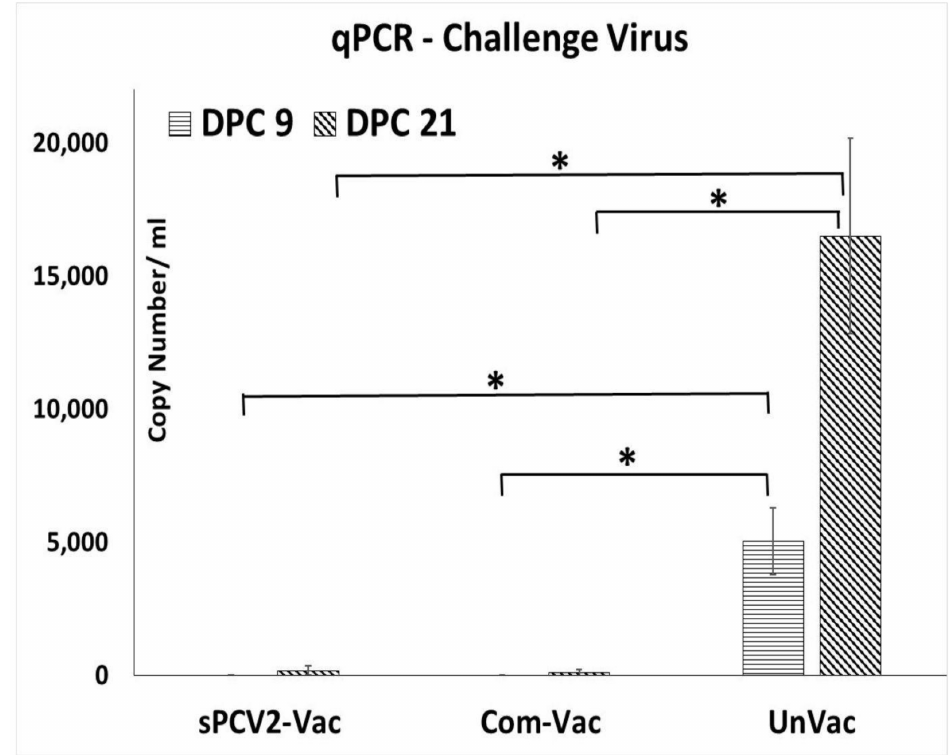
Figure 3. Protection against heterologous challenge viral replication: Challenge viral replication as measured by a PCV2d-specific qPCR. X -axis—treatment groups—horizontal lines—days post- challenge 9, slanted lines—days post-challenge 21, Y -axis—copy numbers/mL serum. Error bars represent the standard error of the mean. * Significantly different from the unvaccinated control group by the Student t -test at p ≤ 0.05 (horizontal